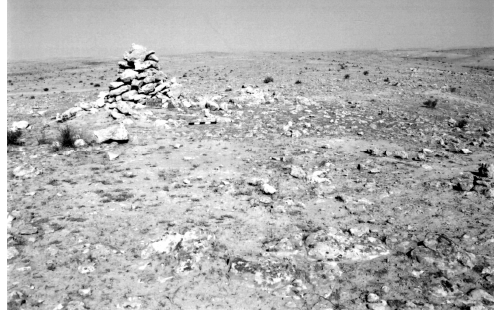
Figure 9. Rujm markers as path-finders on top of a